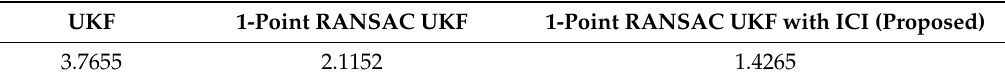
Figure 3. The square error of the simulation. Table 1. RMSE of simulations.